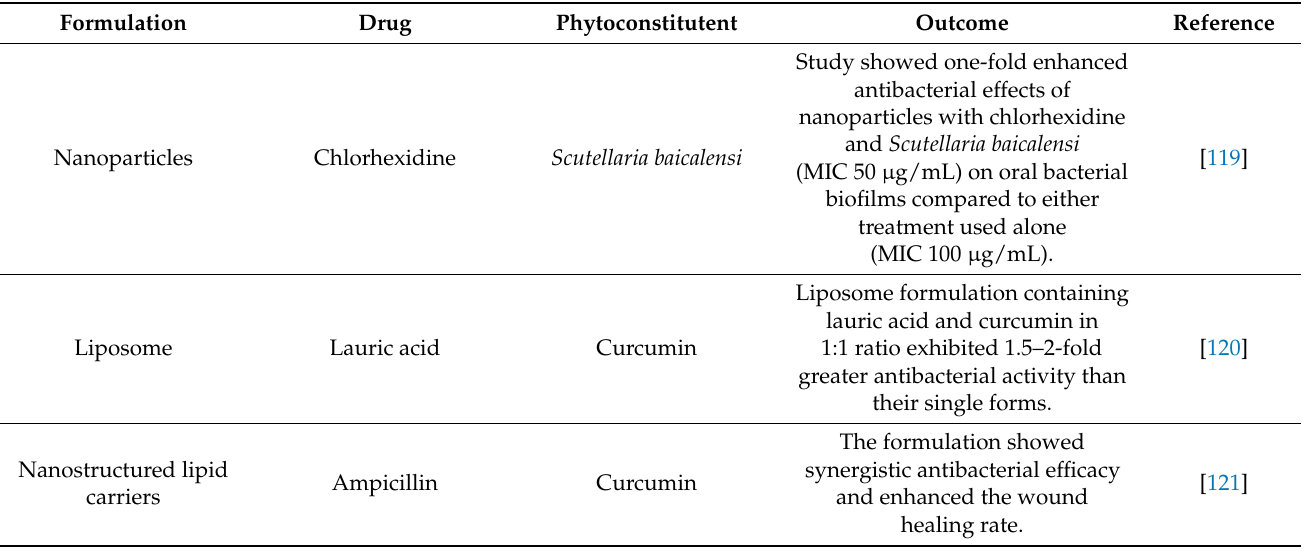
Table 4. Studies showing potential of synergistic combinations of herbal ingredients and synthetic drugs in dental